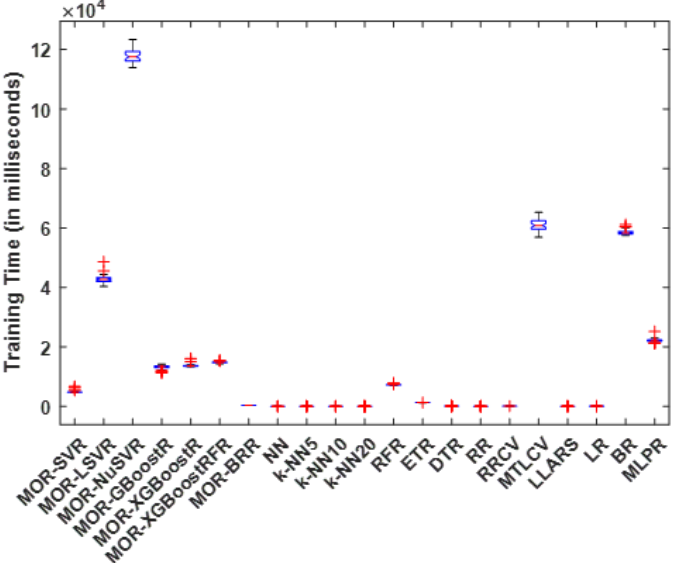
Figure 3. Box plots of TT (over 50 statistical runs) for all methods for the first